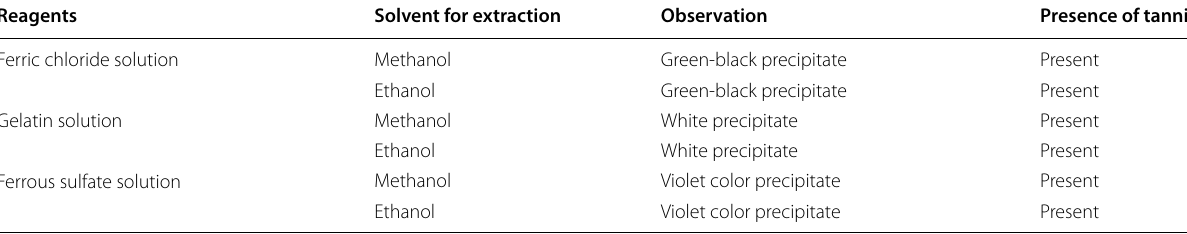
Table 3 Chemical tests for the presence of tannin in Xylocarpus granatum extracted sample